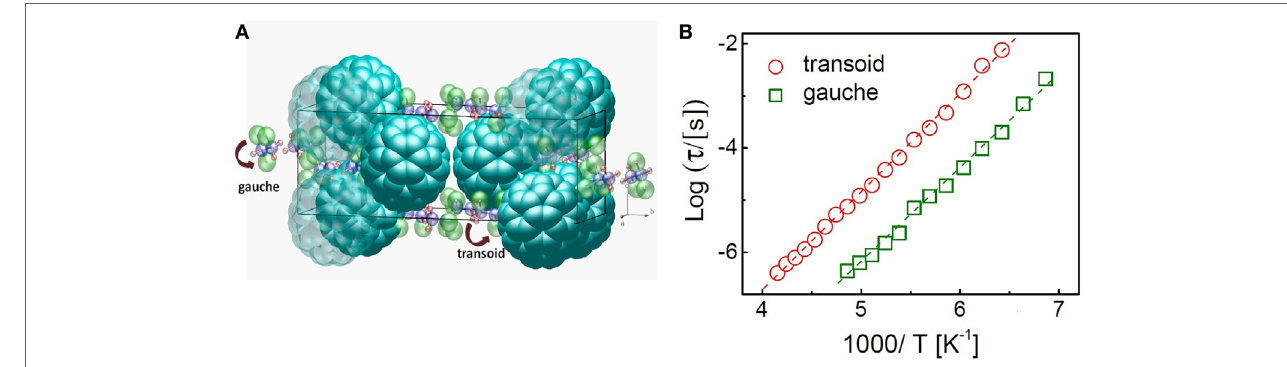
FiguRe 1 | (A) Crystal structure of the 1:1 solvate of C 60 with (1,1,2)trichloroethane. The ethane derivatives are present both as gauche and transoid conformers. (B) Relaxation times of the guest molecules in the solvate. Each relaxation is assigned to a different (1,1,2)trichloroethane conformer. Reprinted with permission from Mitsari et al. (2016b). Copyright 2016 American Chemical Society.